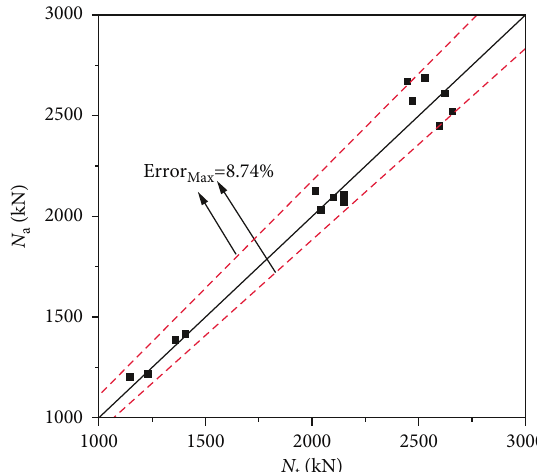
Figure 5: Comparison between N eccentrical